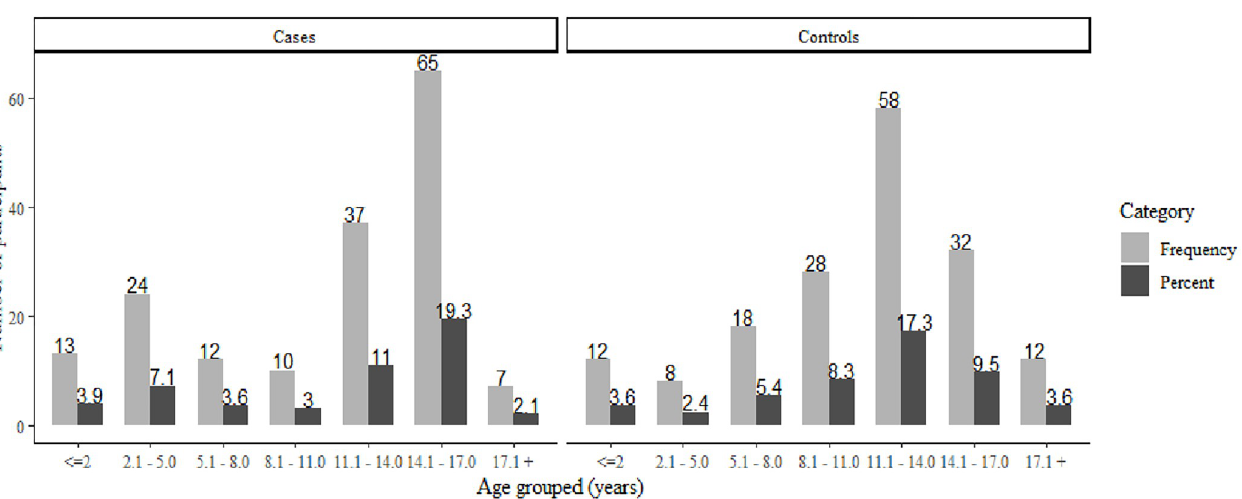
PLOS ONE | https://doi.org/10.1371/journal.pone.0276433 December30,